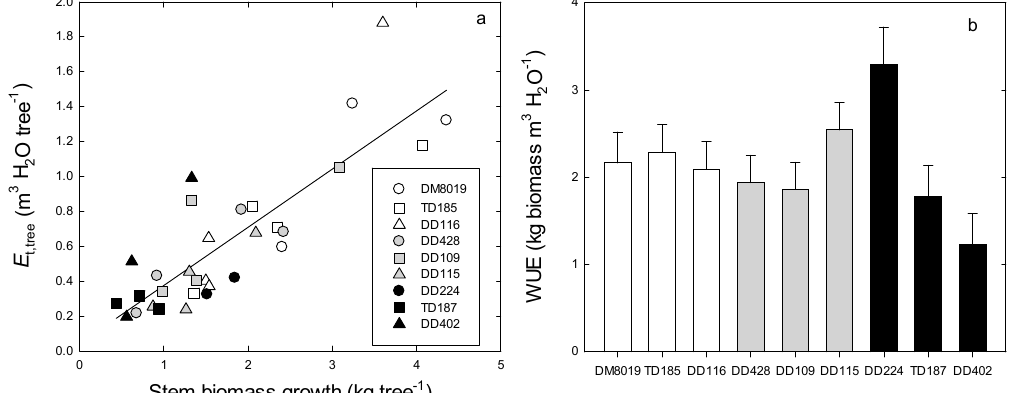
Figure 3. Daily tree water use ( E t,tree , L day − 1 ) in P. deltoides (DD), P. trichocarpa × deltoides (TD), and P. deltoides × maximowiczii (DM) clones. Data are lsmeans and standard error. Open, light shaded, and dark shade bars represent high (Group H), intermediate (Group I), and low (Group L) productivity genotypes, respectively.